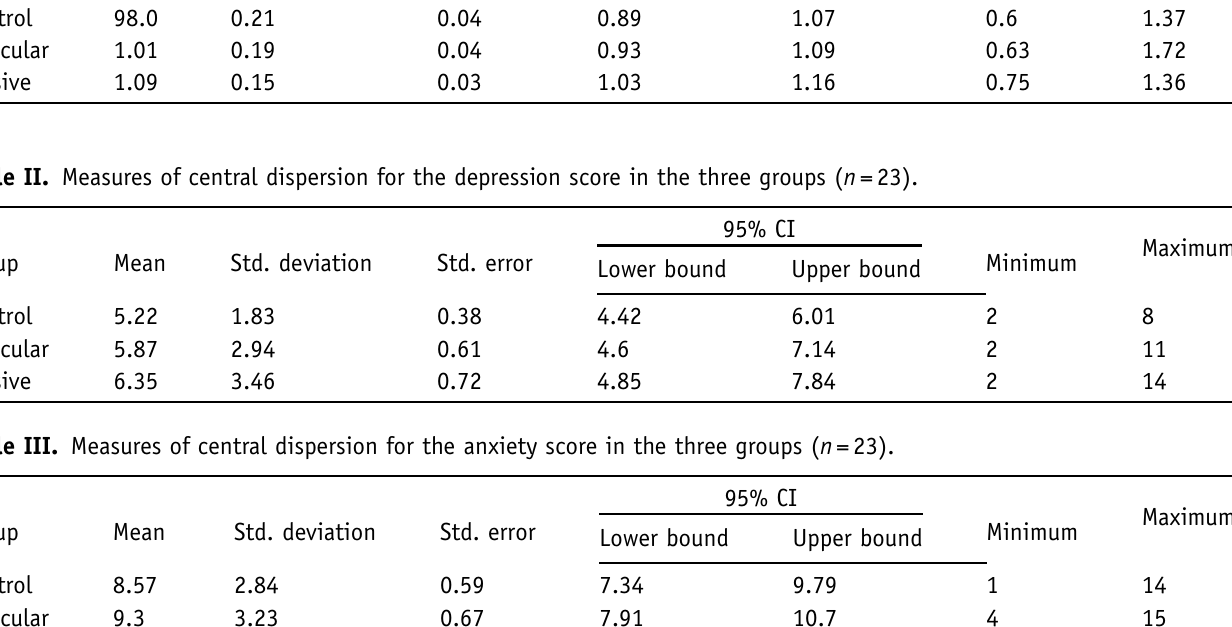
Table I. Measures of central dispersion regarding the salivary level of cortisol ( m g/dL) in the three groups ( n = 23). Group Mean